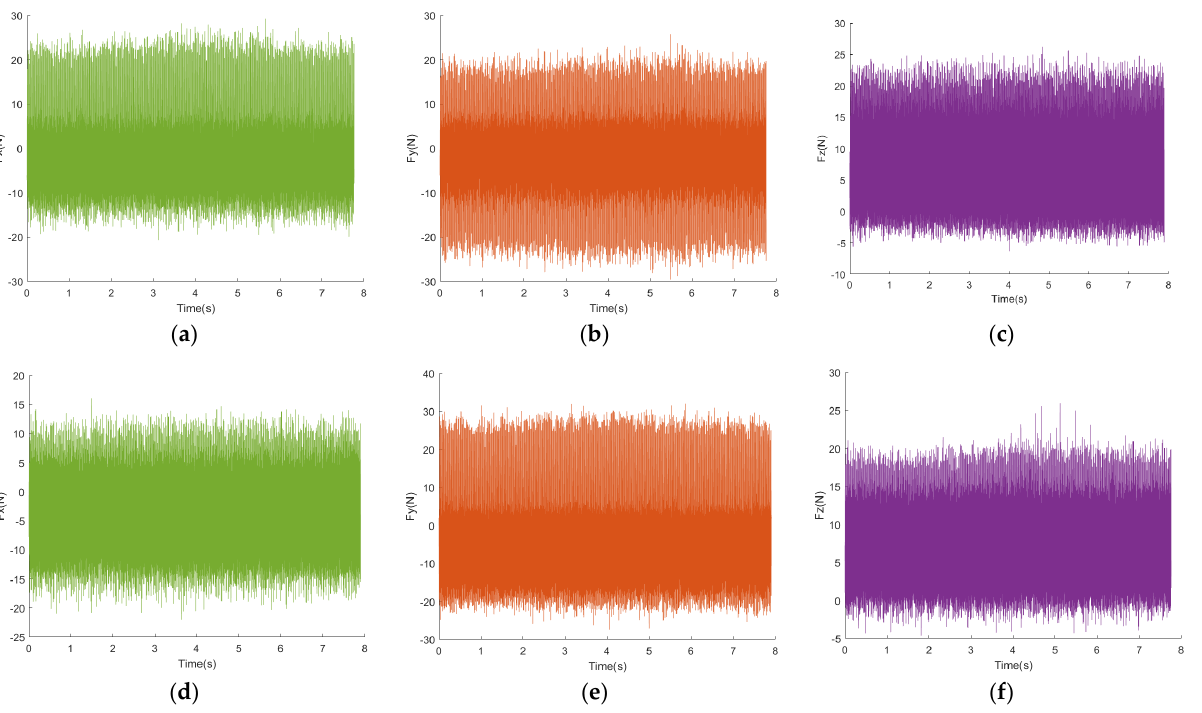
Figure 22. Cutting force: ( a ) F x of DACT; ( b ) F y of DACT; ( c ) F z of DACT; ( d ) F x of BEM; ( e ) F y of BEM; ( f ) F z of BEM.